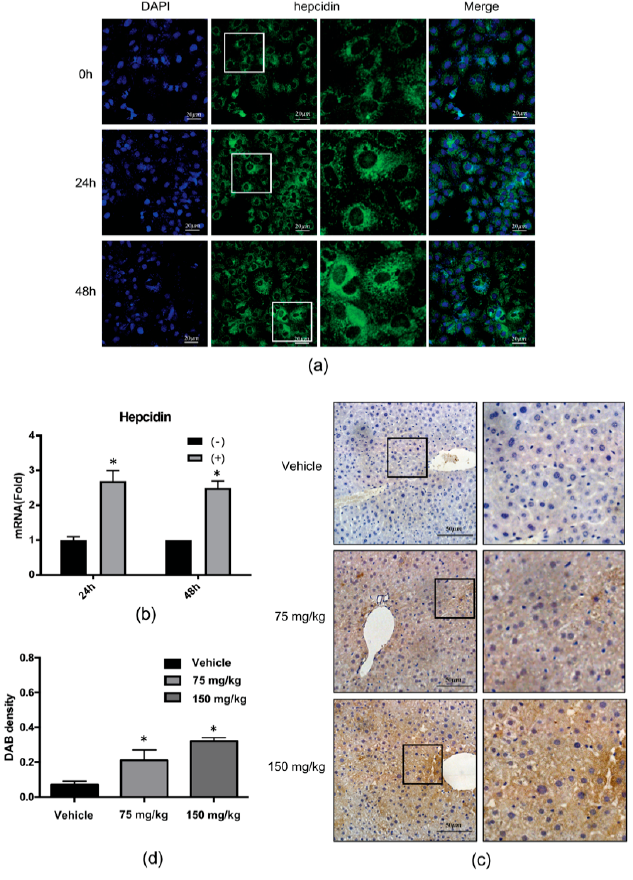
Figure 2. 4-PBA induced hepatic hepcidin expression. ( a ) Indirect immunofluorescence analysis of Huh7.5-Con1 cells with or without 1 mM 4-PBA treatment for 24 or 48 h using antibodies against hepcidin ( green ). DAPI (blue) was used to visualize nuclei. Scale bar = 20 μm . ( b ) After treatment with 1 mM 4-PBA for 24 or 48 h, hepcidin mRNA levels were analyzed by real-time RT-PCR. Data are expressed as means ± SDs of five independent experiments. * P < 0.05 versus the untreated control. ( c ) Immunohistochemical analysis of hepcidin expression in liver tissues of mice, 7 days after treatment with 4-PBA. Scale bar = 50 μm . ( d ) DAB staining was measured with Image J program. Data are expressed as means ± SDs of five independent experiments. * P < 0.05 versus the untreated control. Next, we investigated whether hepcidin induction was associated with epigenetic modification at the hepcidin locus. Chromatin immunoprecipitation (ChIP) qPCR assays were performed with genomic DNA from Huh7.5-Con1 cells treated with 4-PBA for 6, 12, or 24 h. 4-PBA-induced histone acetylation at H3K9 (Figure 3a) and H3K27 (Figure 3b) in a time-dependent manner. In particular, histone acetylation at H3K27 was increased by 2–3-fold after 4-PBA treatment. We also found that 4-